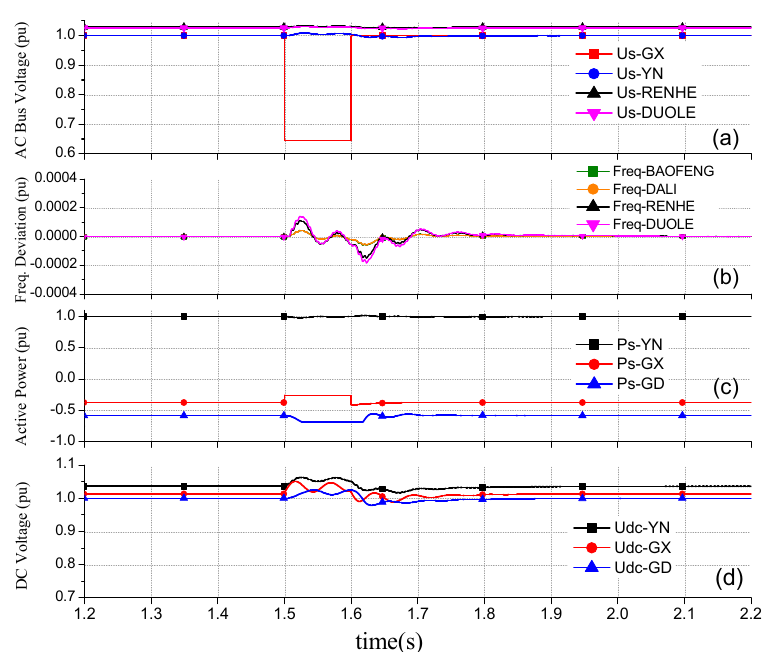
Figure 10. Dynamic performances of the hybrid multi-terminal HVDC system under GX bus fault. ( a ) AC bus voltage; ( b ) Frequency deviation; ( c ) Active power; ( d ) DC voltage. 2. AC fault at the receiving-end GD MMC station: In this case, a three-phase short circuit fault with 0.1 s duration is applied at the bus of receiving-end GD MMC station, leading the bus voltage drops to 0.48 pu during the fault. The dynamic responses are shown in Figure 11.